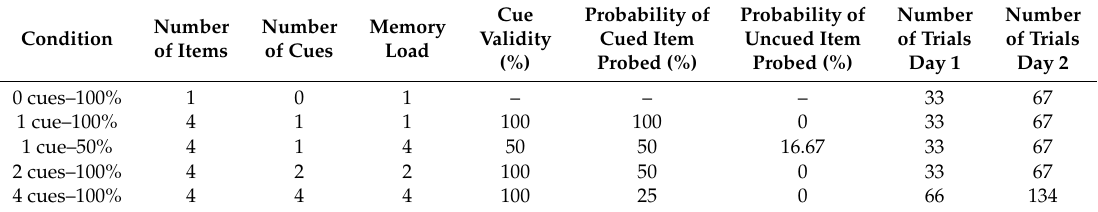
Figure 1. ( A ) Example trial from the delayed-recall task. Participants were shown a sample array for 500 ms with either one (in the 0 cue condition) or 4 squares (with 1, 2, or 4 line cues), which were blocked according to cue number and validity (conditions described in Table 1). Following a 1000 ms retention interval, a dark outline surrounded the square required to be recalled. Participants were required to select a colour on the colour wheel that matched the probed location in the sample array. ( B ) Sample arrays of all the trial conditions. Table 1. Condition parameters and trial information.